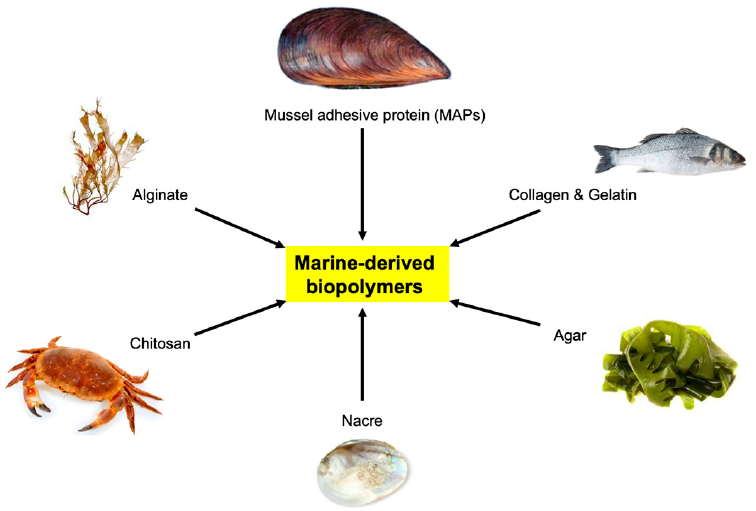
Figure 4. A graphical representation of some of the most commonly researched marine-derived bi- biopolymers that are used within the field of opolymers that are used within the field of dentistry.